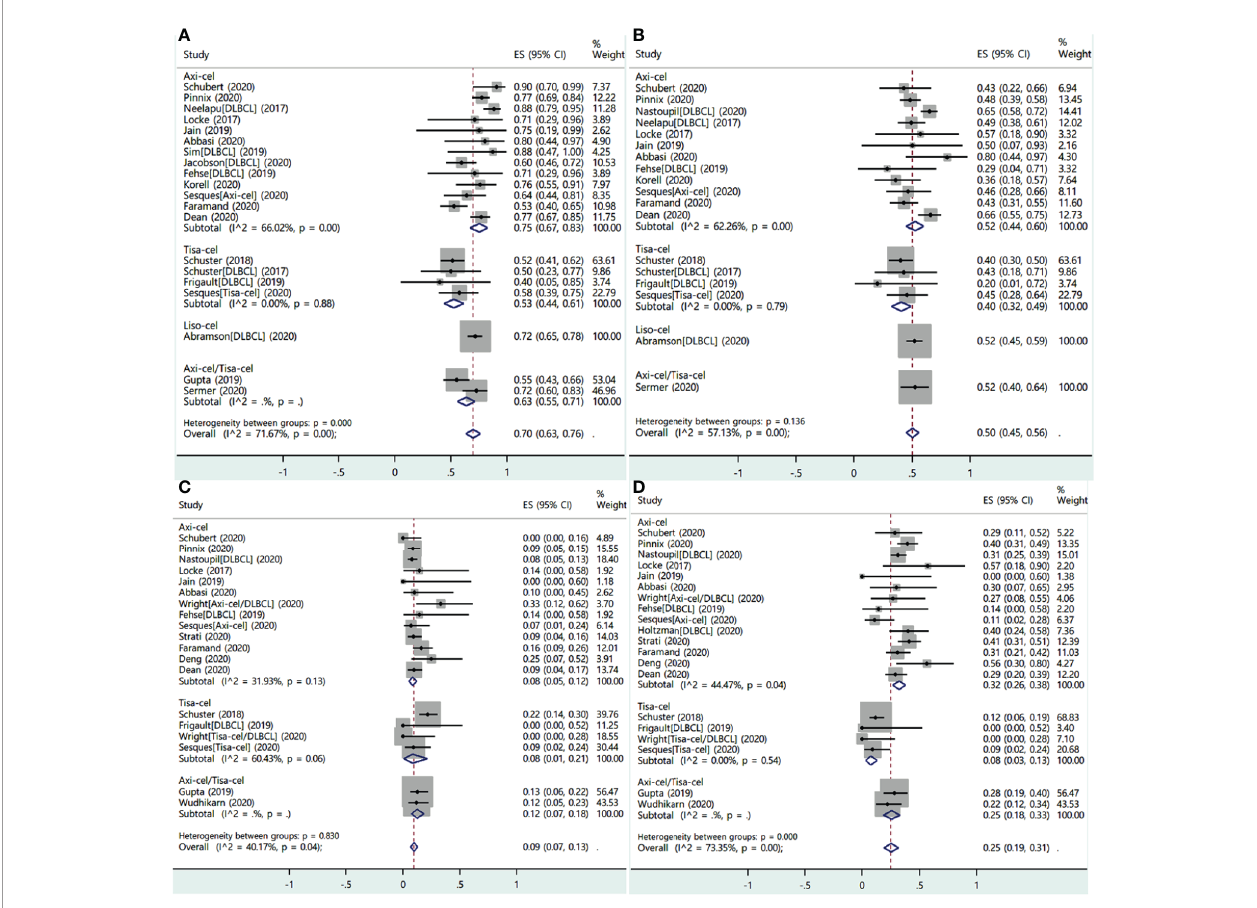
FIGURE 6 | The forest plots of pooled results in patients with diffuse large B-cell lymphoma. (A) The forest plot of overall response rate of each product. (B) The forest plot of complete response rate of each product. (C) The forest plot of severe cytokine release syndrome rate of each product. (D) The forest plot of severe immune effector cell-associated neurotoxicity syndrome rate of each